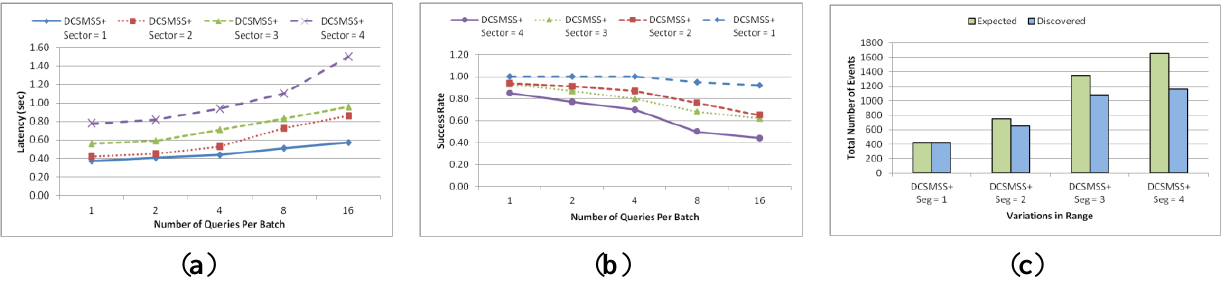
Figure 14. ( a ) Latency; ( b ) success rate and ( c ) total number of events.